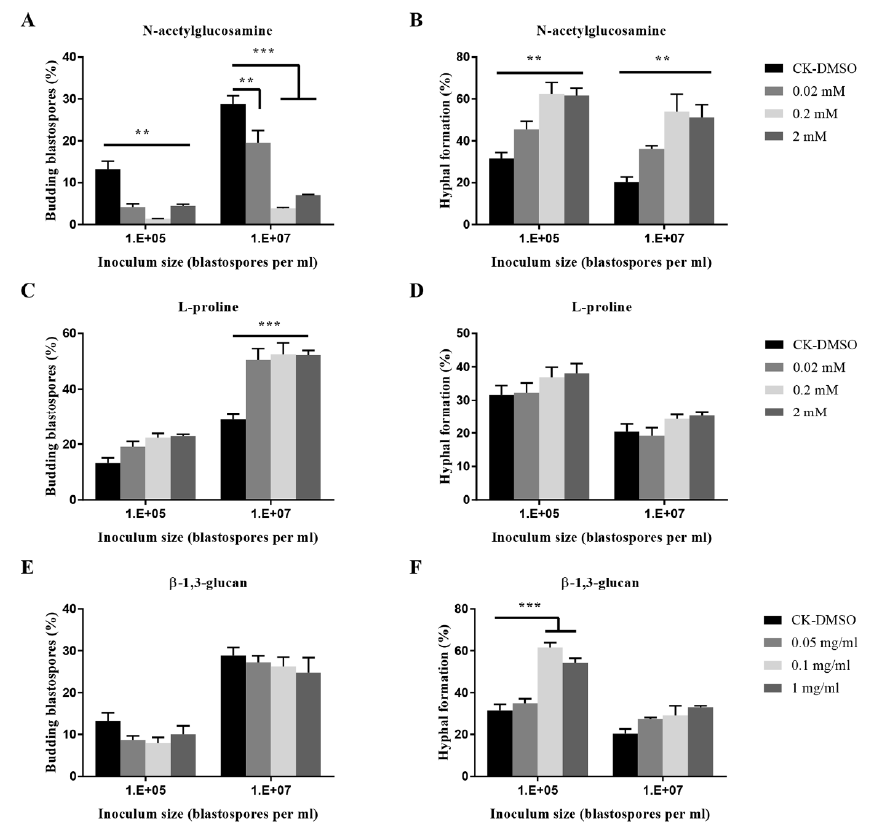
Figure 4. Effects of nutrient inputs on blastospores budding growth ( A,C,E ) and hyphal formation ( B,D,F ) of O. sinensis in liquid PM medium 8 days after inoculation. p < 0.05 (*), p < 0.01 (**) and p < 0.001 (***).